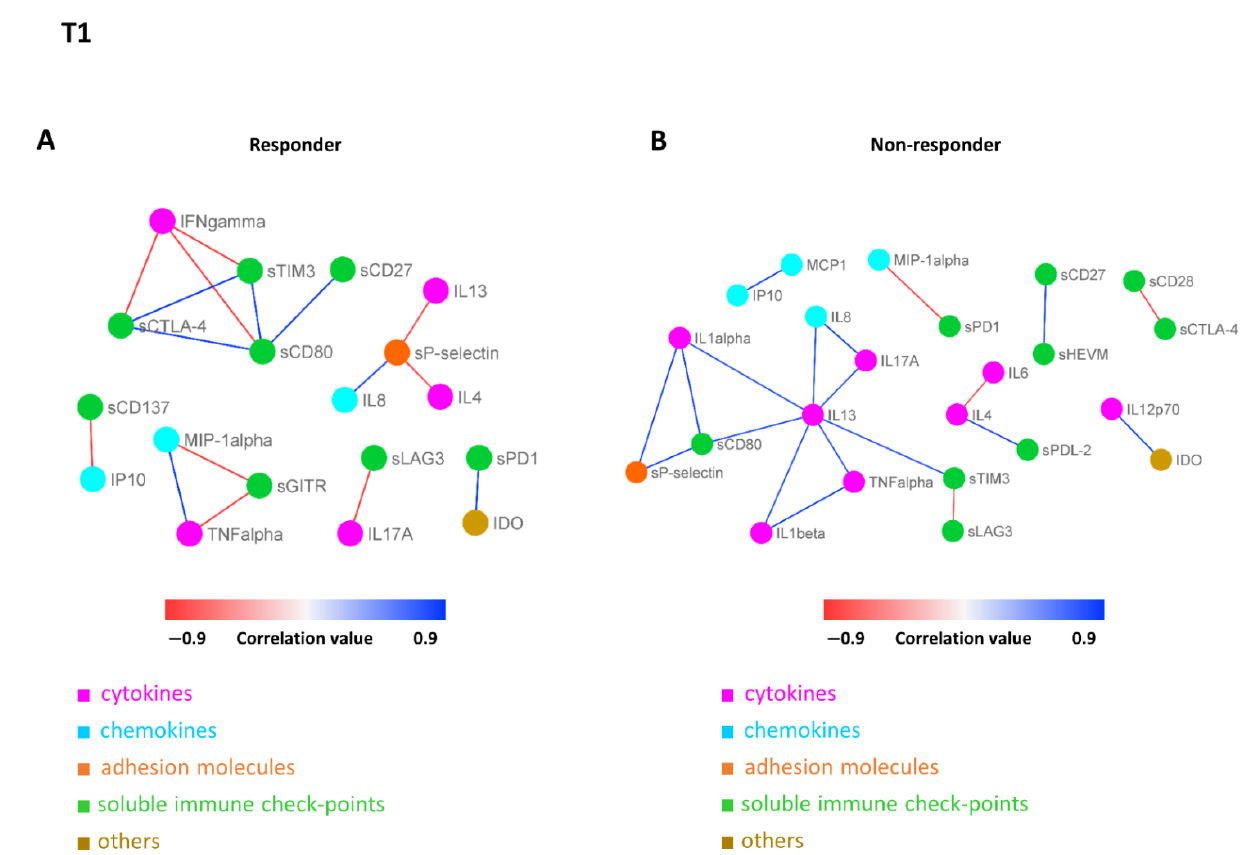
Figure 7. Connectivity network between molecules in responder ( A ) and non-responder ( B ) patients at T1. In each network, nodes represent molecule, and a link occurs between two nodes if the absolute value of Spearman correlation between their expression levels is statistically significant ( p -value ≤ 0.05) and greater than a selected threshold (i.e., the 85th percentile of the overall distribution corresponding to 0.8). Nodes are colored according to the functional groups reported in the legend, whereas edge colour indicates positive (blue) or negative (red) correlation values.